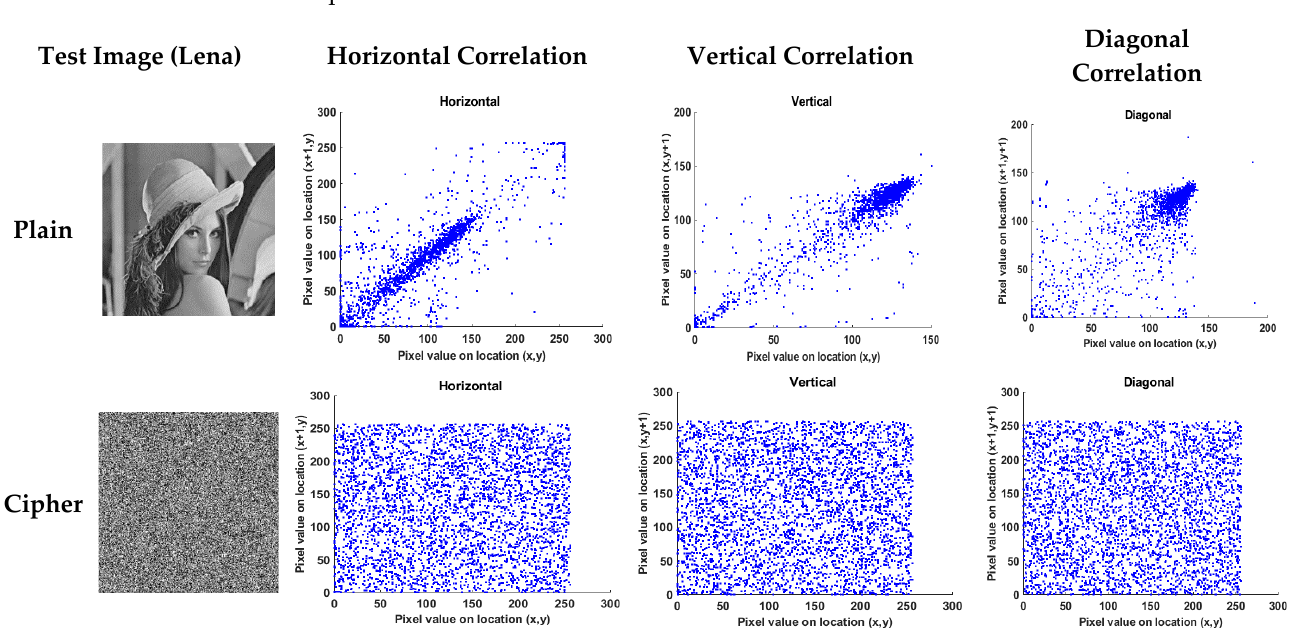
Figure 8. Pixel distribution in horizontal, vertical and diagonal directions. Table 2. Correlation analysis of Proposed versus Existing